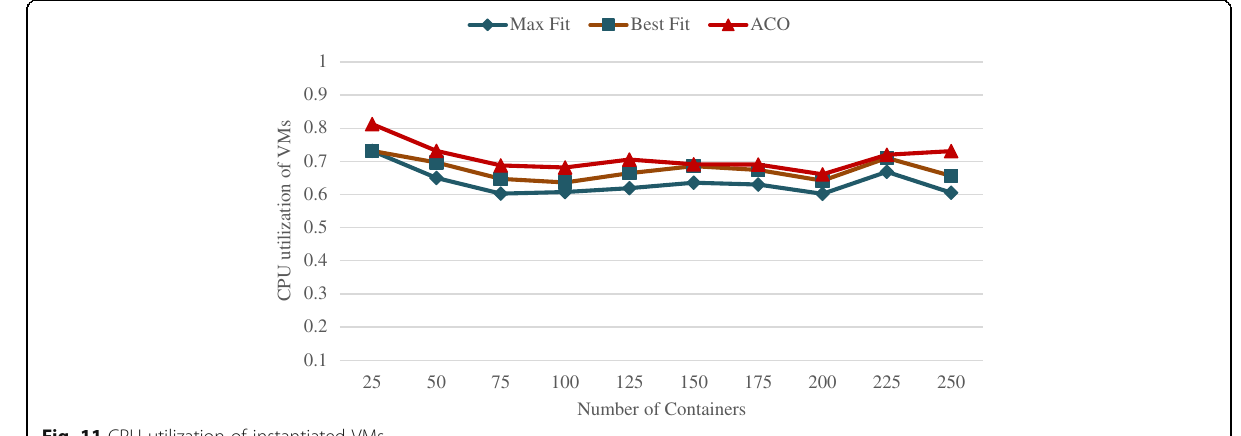
Fig. 11 CPU utilization of instantiated VMs